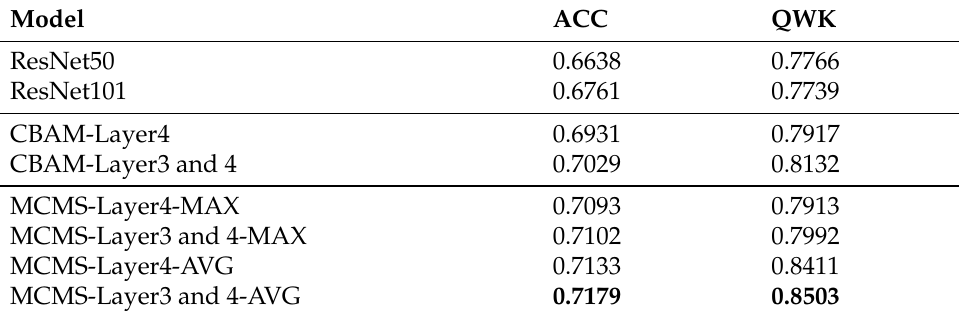
Table 2. Results of model evaluation in ACC and